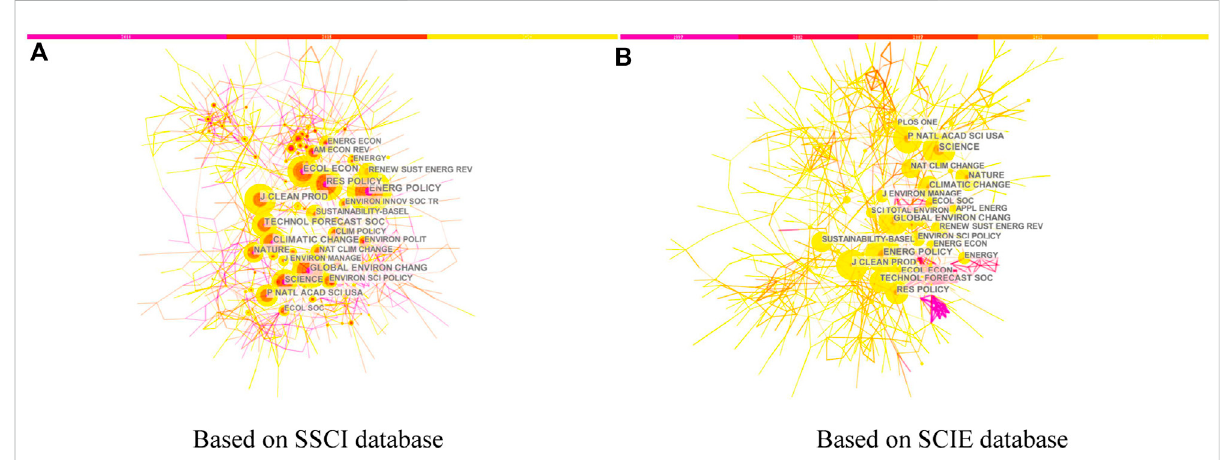
FIGURE 5 Map of the journal co-citation network of climate innovation research. (A) refers to the SSCI database and (B) refers to the SCI database.